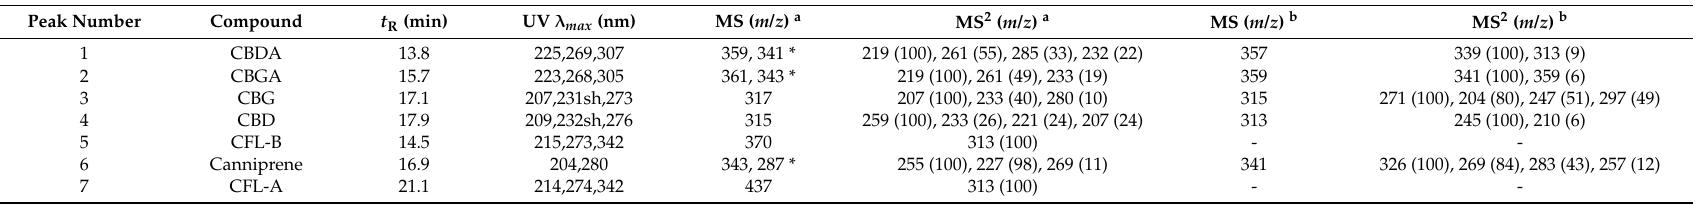
Table 1. Retention times, UV, MS, and MS 2 data of the main non-psychoactive cannabinoids, flavonoids and related compounds in hemp